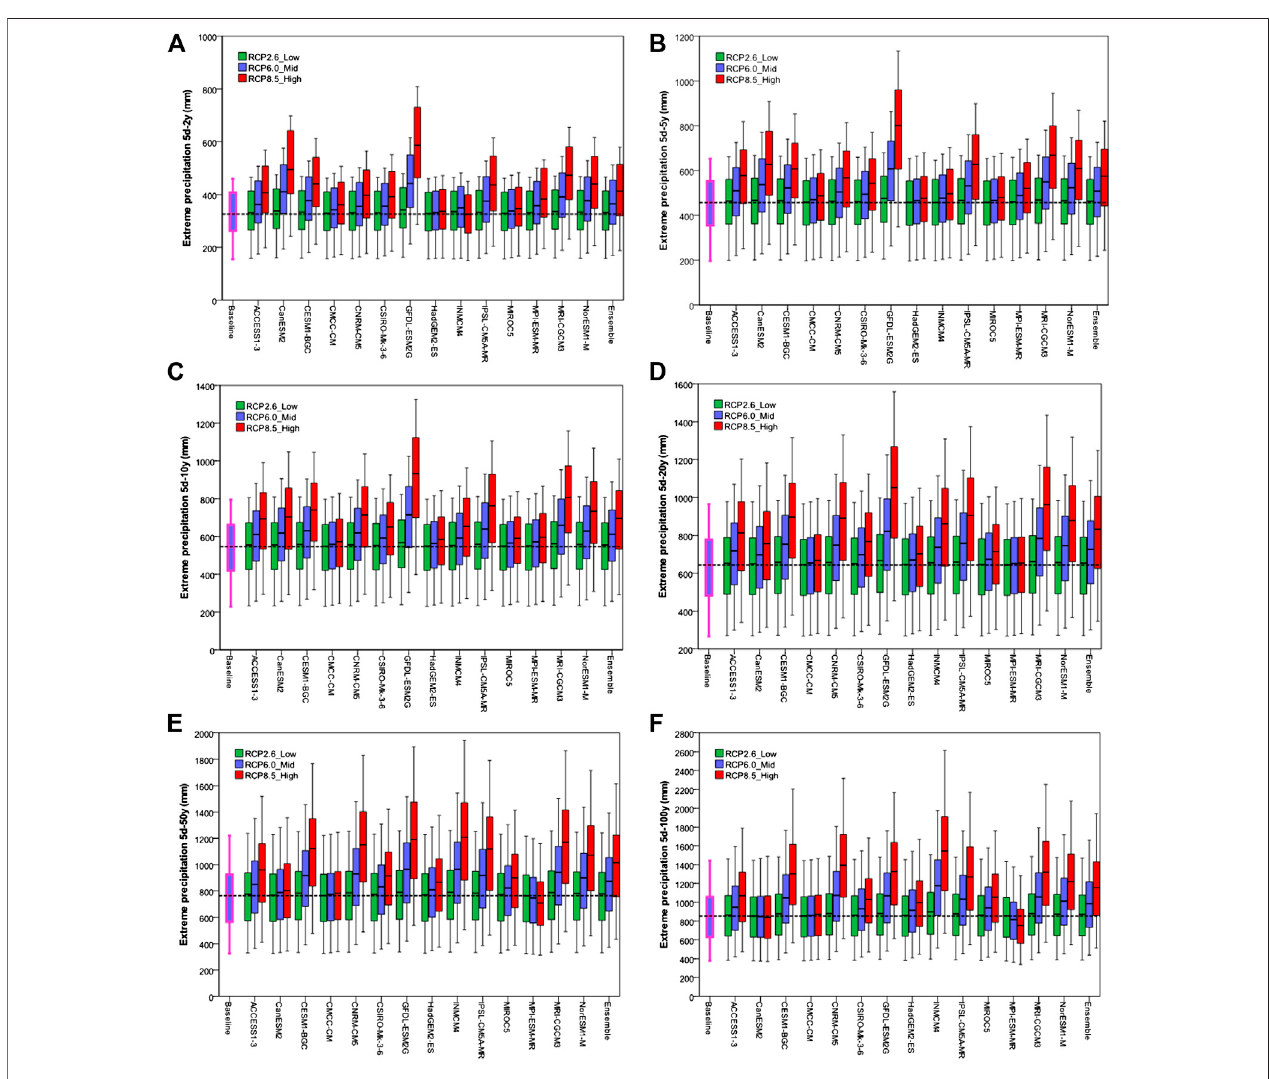
FIGURE5| Variationofprojected5-dayextremeprecipitationunder14GCMsandtheirensemblein2070correspondingtodifferentreturnperiods:T (cid:2) 2 years (A) , T (cid:2) 5 years (B) , T (cid:2) 10 years (C) , T (cid:2) 20 years (D) , T (cid:2) 50 years (E) , and T (cid:2) 100 years (F) . Figure presents data of 20 monitoring stations